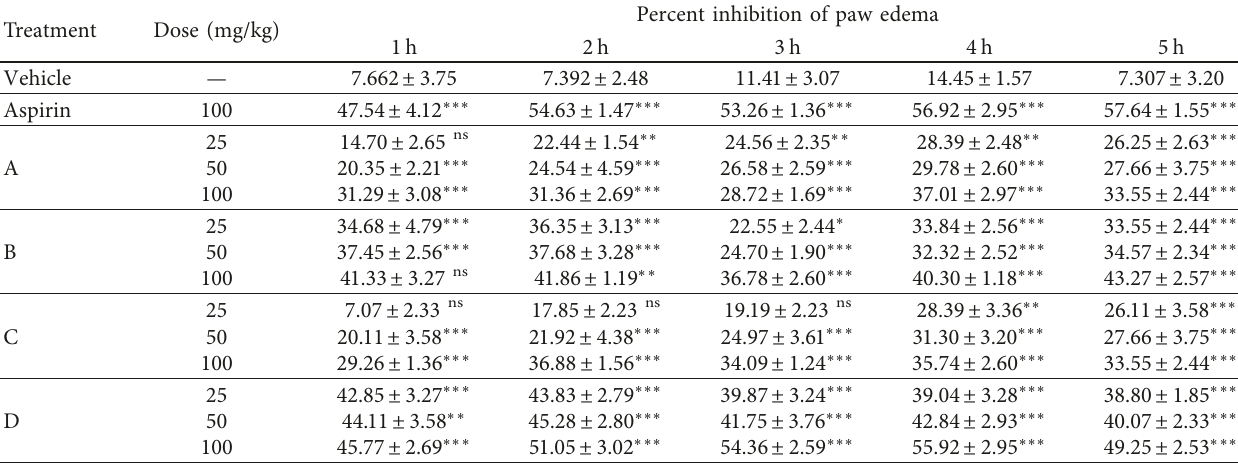
Table 3: Percentage inhibitions of compounds in the carrageenan-induced paw edema.